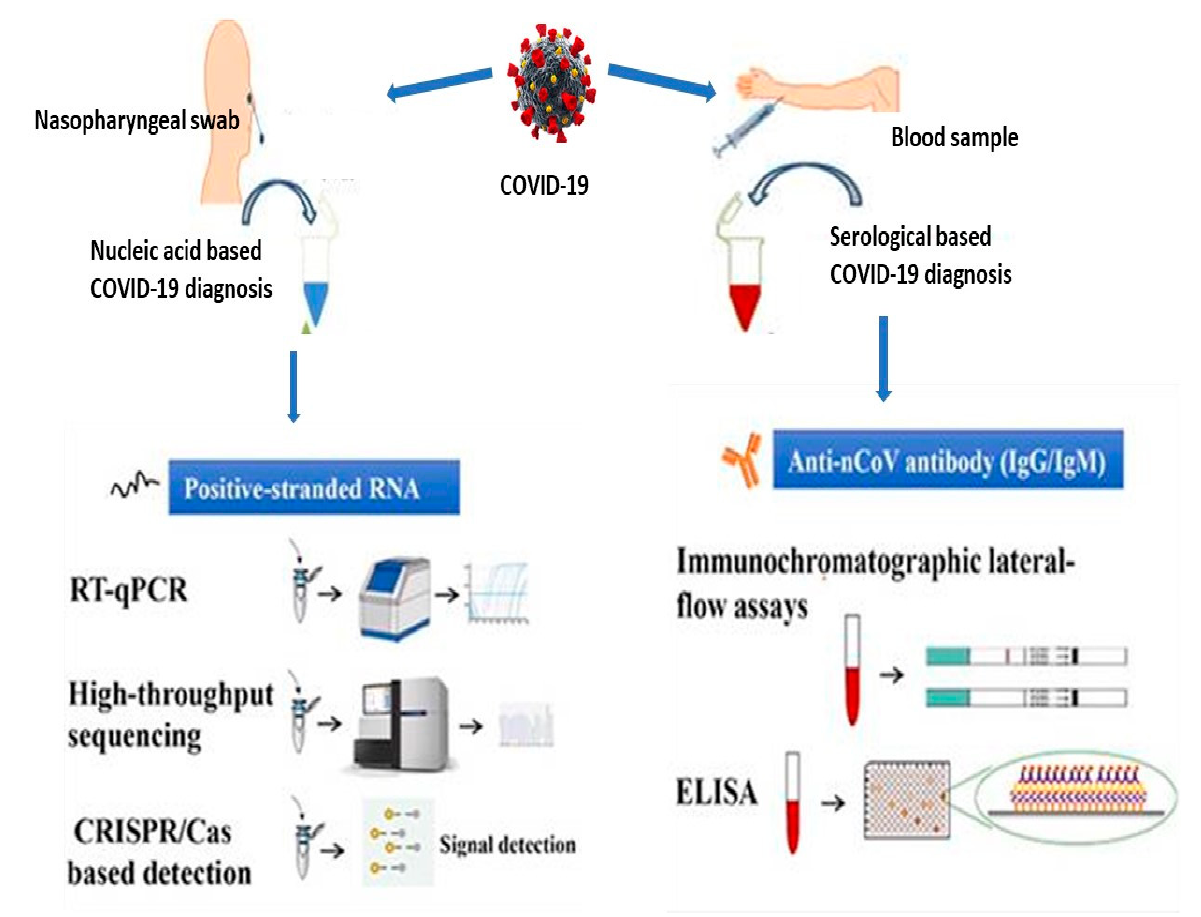
Figure 2. Schematic presentation of different molecular detection approaches and sample collection techniques for COVID-19. Adapted with permission from Ref. [64]. Copyright 2020, Frontiers.